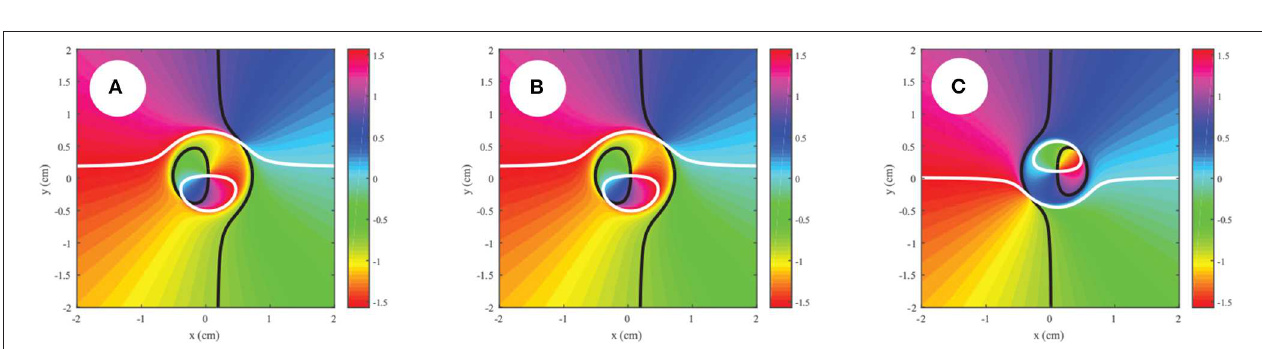
(0.35,0.35) cm. The unit vector =